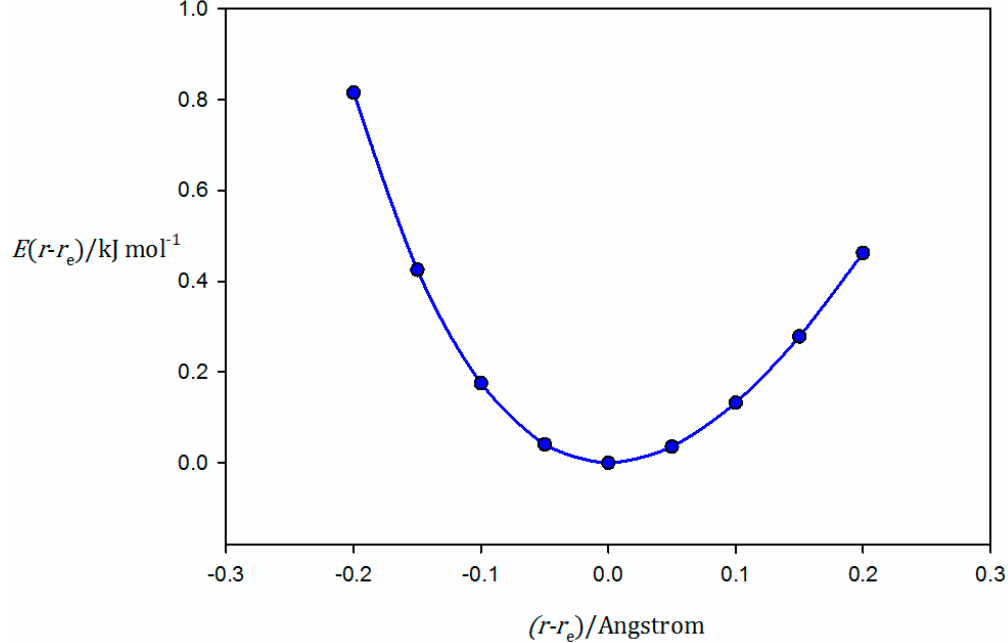
Figure 2. The variation in E ( r − r e ) with r − r e , used to calculate the intermolecular quadratic force k σ (the curvature at the minimum) for H 3 N ⋯ S=C=S at the CCSD(T)/aug-cc-pVTZ level of theory. The curve is a third-order polynomial fit to the calculated points ( R 2 of fit = 0.9998). The polynomial was differentiated twice to obtain k σ .